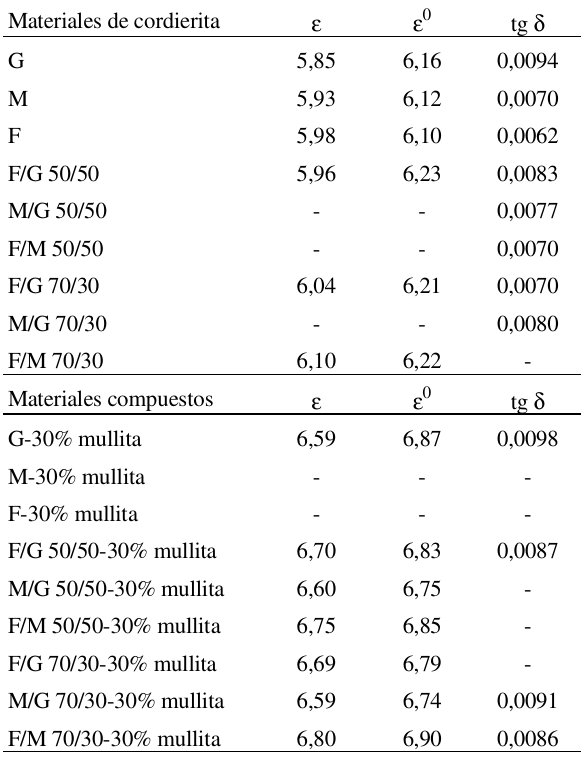
Tabla 2. Valoresde la constante dieléctrica ( ε ), de la constante dieléctrica corregida a porosidad cero ( ε 0 ) y del ángulo de pérdida (tg δ ) de los materiales de cordierita y cordierita-30%